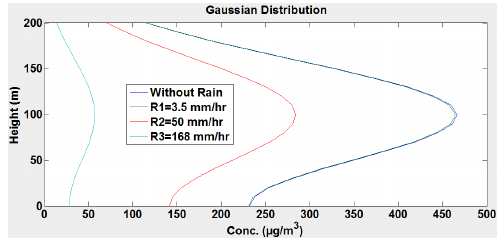
Fig. 7. Vertical Profiles of the depleting Gaussian Plume